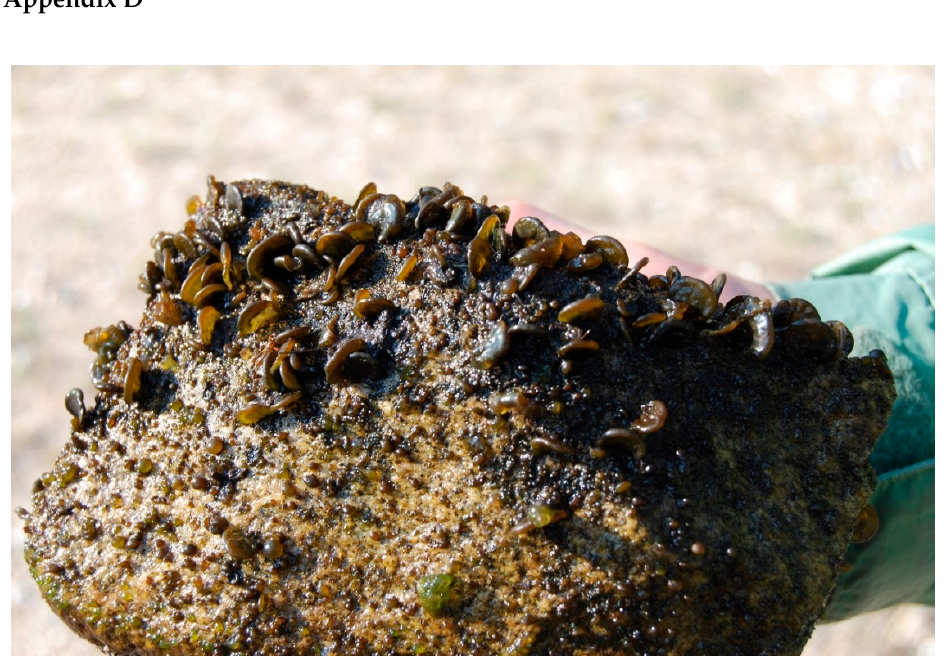
Figure C1. Mean relative standard error (RSE = standard error/mean) values across all quantitative variables measured in each sampling reach and year. Higher values reflect greater variability, or heterogeneity, between the 10 transects sampled in each reach and year relative to the mean value measured in those transects. Included variables are shown in Table C1. Error bars show ± 1 SE for crosshatched bars. Groups with the same letter (i.e., a–e) are not significantly different ( α = 0.05) according to Duncan’s Multiple Range Test.